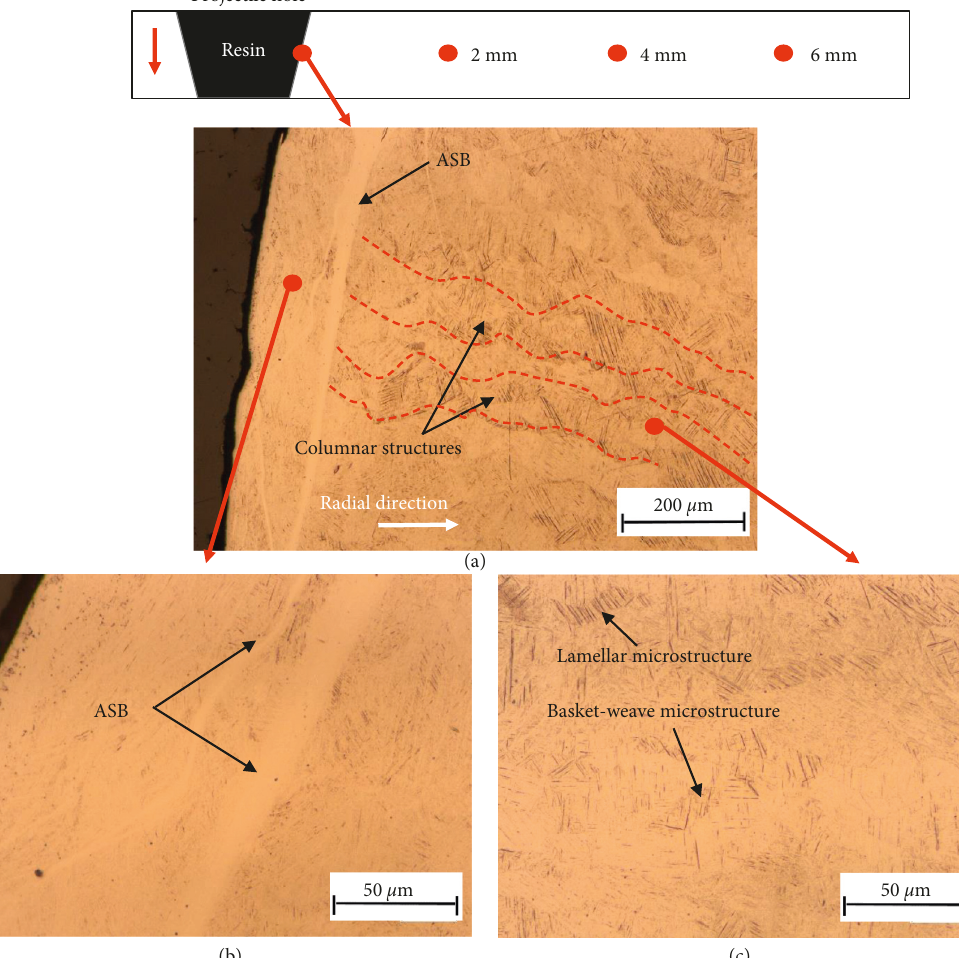
Figure 16: (a) Optical micrograph, (b) and (c) higher magnification optical micrographs, all near the edge of the projectile hole through a 10mm thick plate.